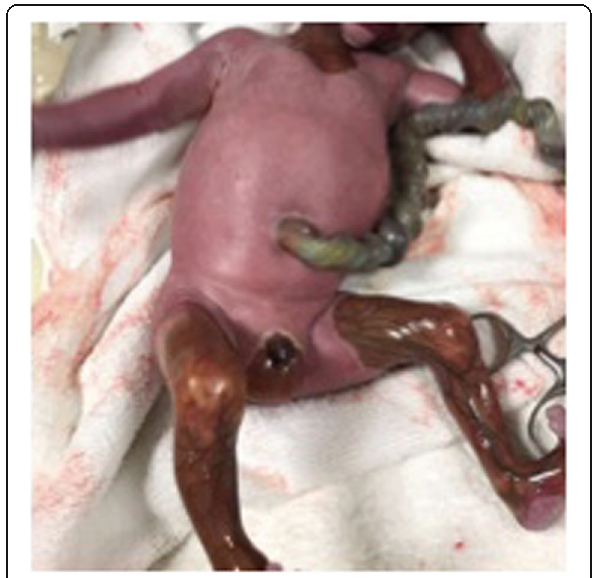
Fig. 3 Radiograph of the abdomen showing gastric dilatation due to pyloric